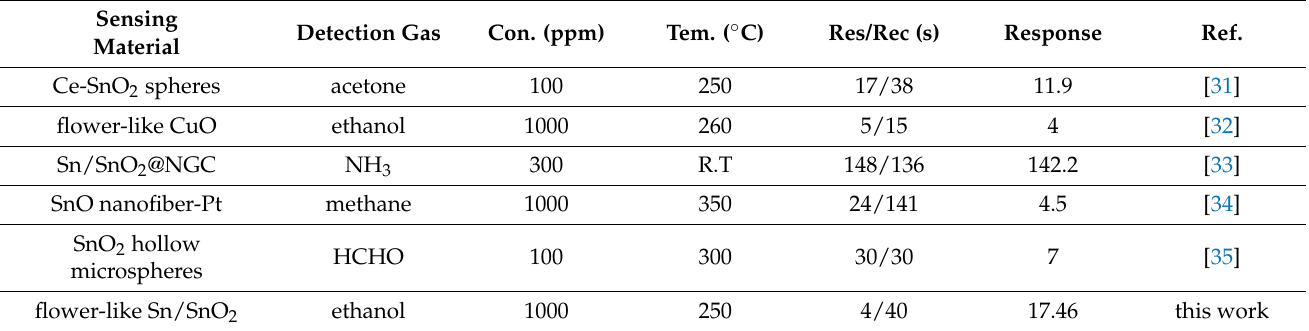
Figure 11. Schematic diagram of the possible gas-sensing mechanism of Sn/SnO 2 samples. ( a ) Schematic diagram of gas sensing mechanism of gas sensor, ( b , c ) The energy band structure of pure and Sn-doped SnO 2 .